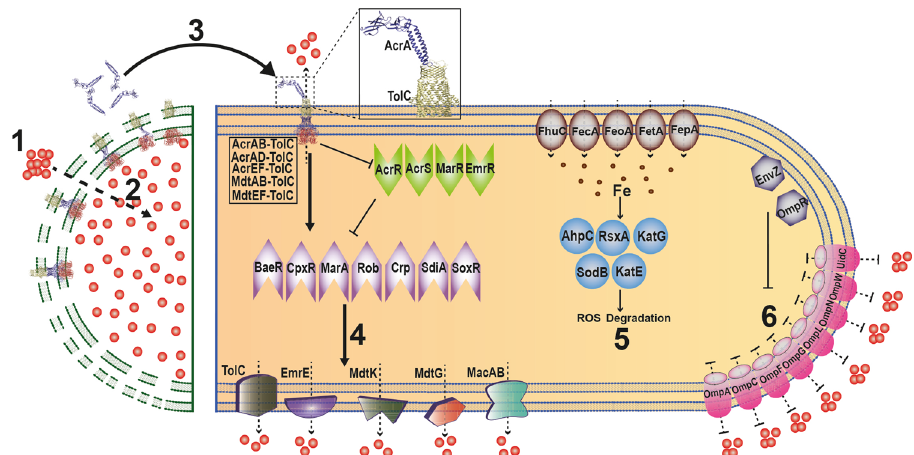
Fig. 6 Model showing how necrosignaling promotes SR. Both live and dead cells are represented in a single cartoon. 1 Antibiotic uptake (red dots). 2 Cell death, membrane damage. 3 Released AcrA binds to TolC in the OM of live cells, activating ef fl ux from TolC pumps. 4 A secondary consequence of TolC activation is upregulation of fi ve categories of ef fl ux pumps. This upregulation is enabled by mulitple activators (purple), or by repression of multiple repressors (green). 5 Upregulation (arrowhead) of genes that reduce ROS (blue and brown) would allow tolerance of the antibiotic stress. 6 Downregulation ( fl athead) of porins (purple) would restrict entry of